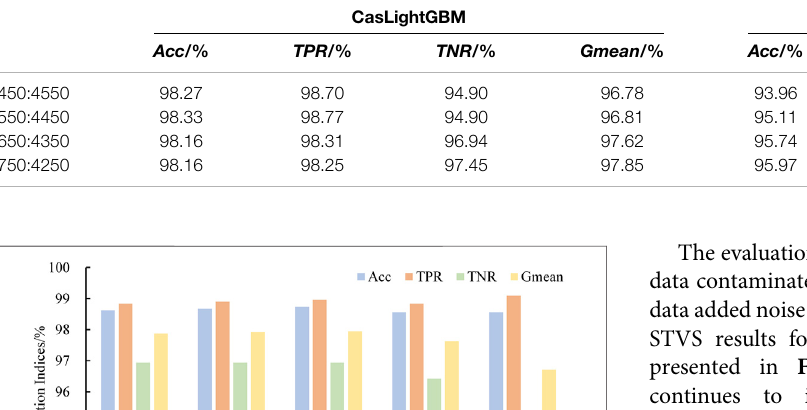
TABLE 5 | Assessment results of different amounts of unstable training samples.